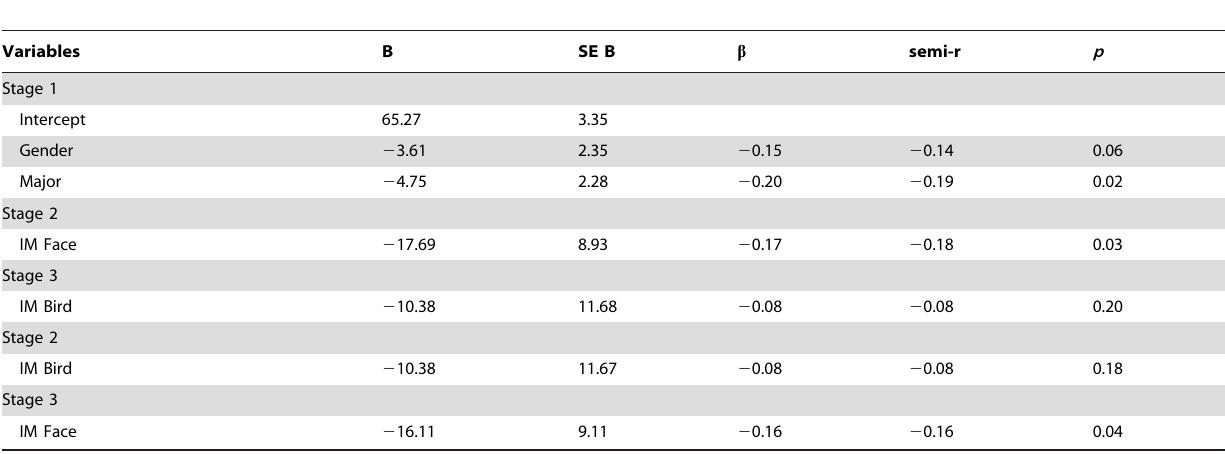
Table 4. Hierarchical regression on Autism Quotient scores as a function of university major, gender, face recognition, and bird